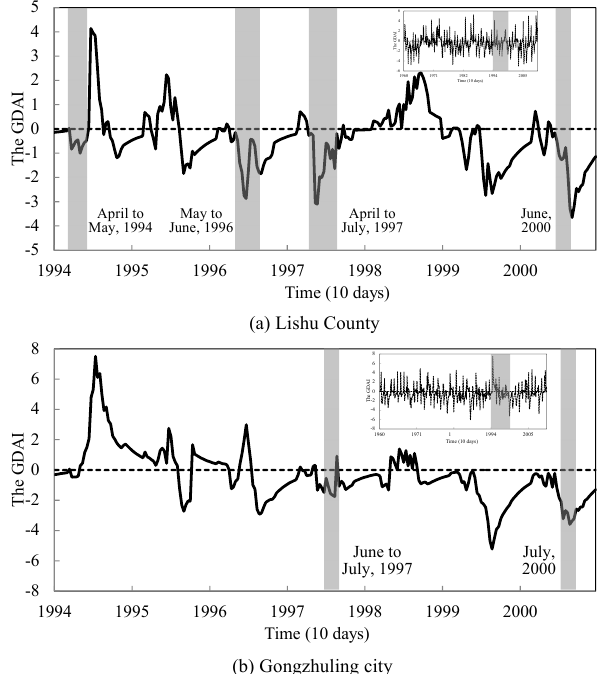
Figure 2. Compared the results evaluated by the GDAI and the ob- served drought disaster records (1960–2010). Note: parts in gray were the periods of the observed drought disaster